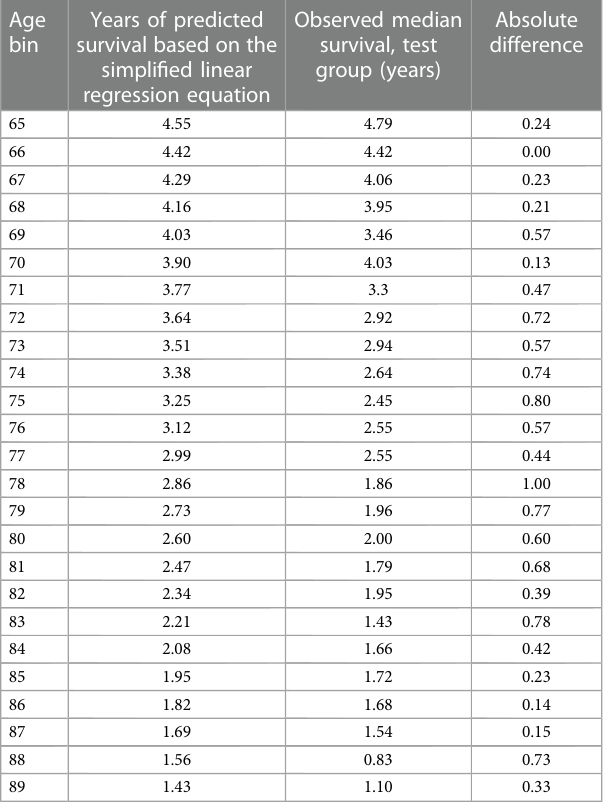
TABLE 4 Accuracy of the simpli fi ed equation, survival=13 – (0.13×Age). Age Years of predicted Observed bin survival based on the simpli fi ed linear regression equation